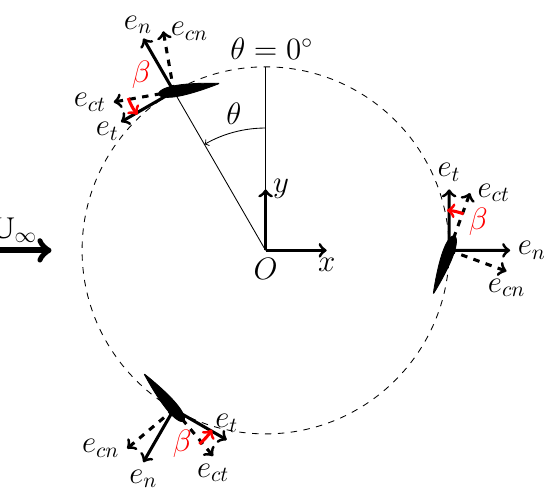
Figure 2. Definition of the blade pitch angle β . ( (cid:126) e ct , (cid:126) e cn ): coordinate frame attached to the blade (i.e., (cid:126) e ct remains parallel to the blade’s chord at all time). ( (cid:126) e t , (cid:126) e n ): coordinate frame that follows the blade path with (cid:126) e t parallel to the tangent to the trajectory of the quarter chord at all time. The pitch angle β is the angle between (cid:126) e ct and (cid:126) e t .